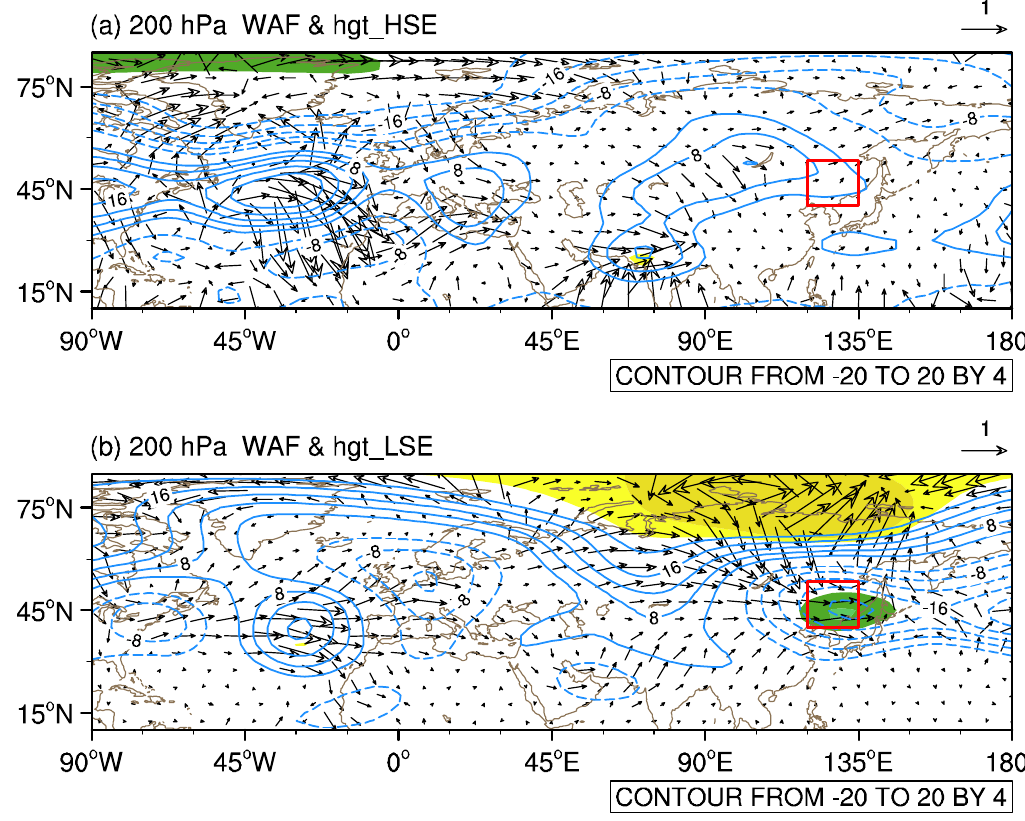
Figure 9. The 200-hPa wave activity flux (vectors; units: m 2 s − 2 ) with geopotential height anomalies (contours; units: gpm): ( a ) anomalies in the composite of more HSE years; ( b ) anomalies in the composite of more LSE years. Shading denotes where the anomalies are significant at the 90% confidence level.